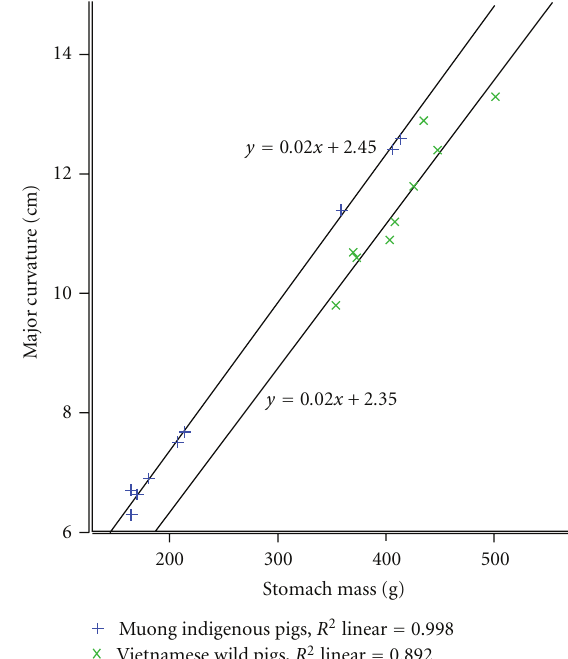
Figure 4: Comparative correlation of minor curvature to stomach